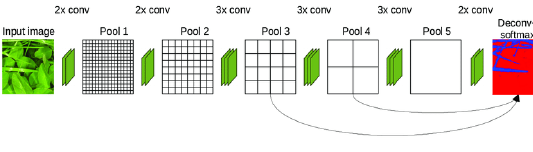
Figure 3. FCN-8s architecture (Skovsen et al., 2017)